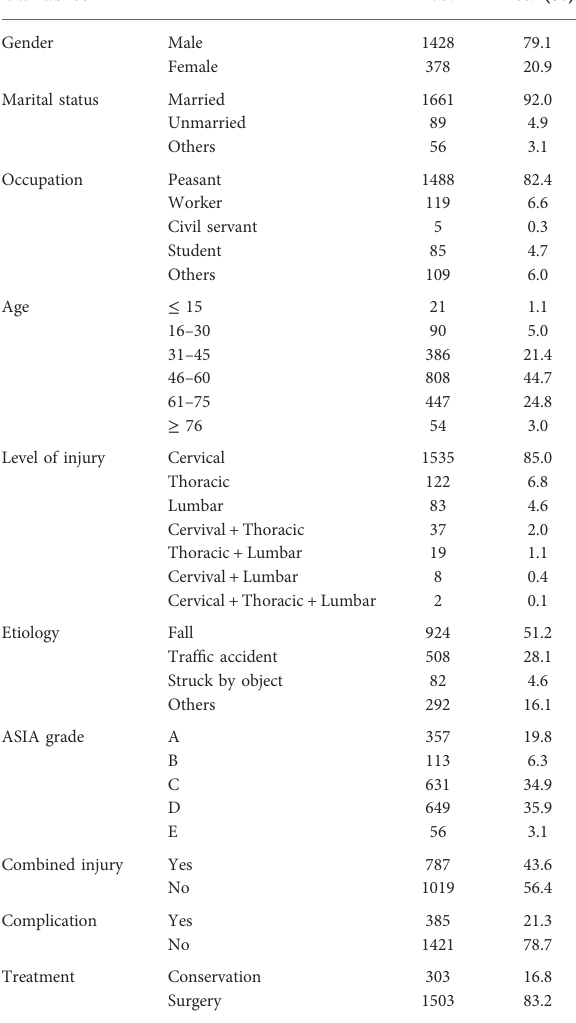
TABLE 1 Characteristics of 1,806 TSCI patients.